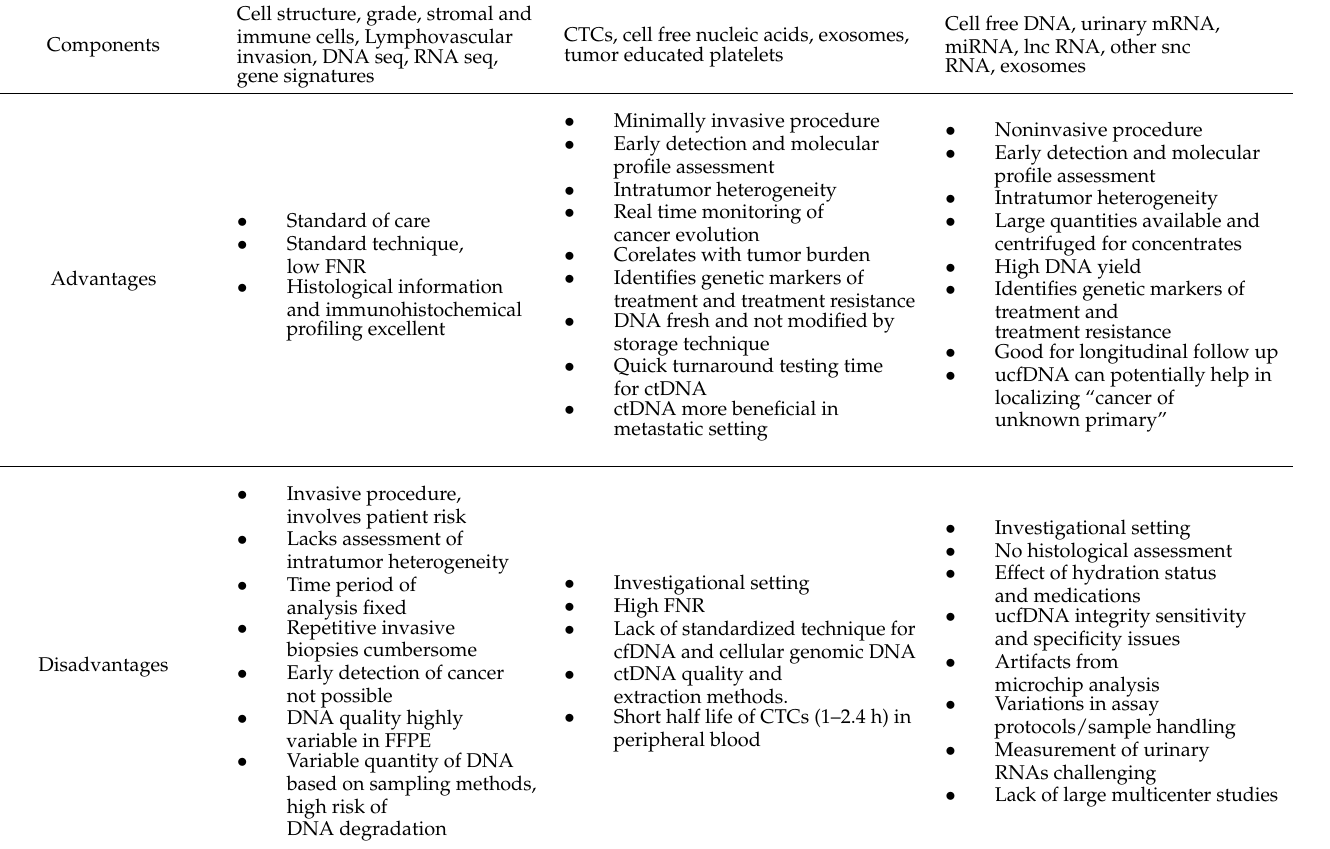
Table 1. Advantages and disadvantages of standard tissue biopsy versus blood liquid biopsy versus urine liquid biopsy. Standard Tissue Biopsy Blood Liquid Biopsy Urine Liquid